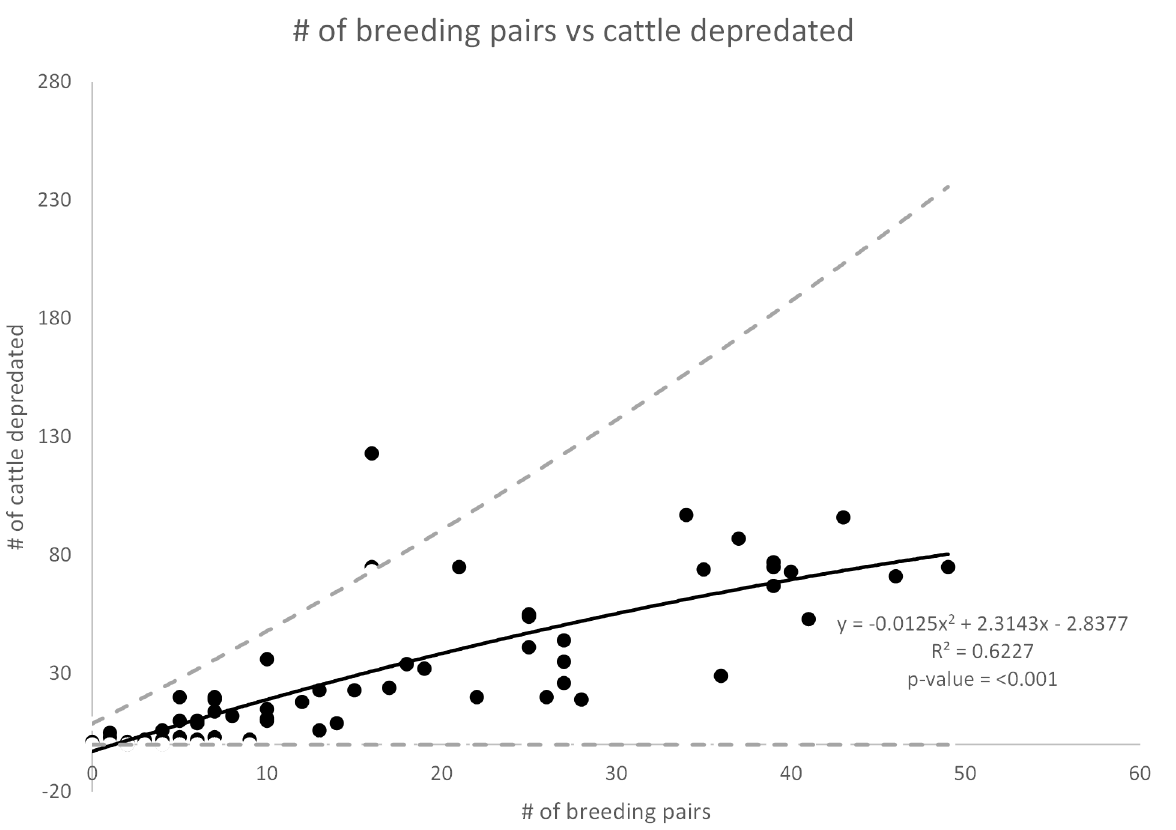
Figure 2. Number of breeding pairs vs cattle depredated. Number of breeding pairs present on the landscape the previous year versus the number of cattle depredated the following year. The dashed lines show the upper and lower limits of the 95% confidence interval for the best fit line.